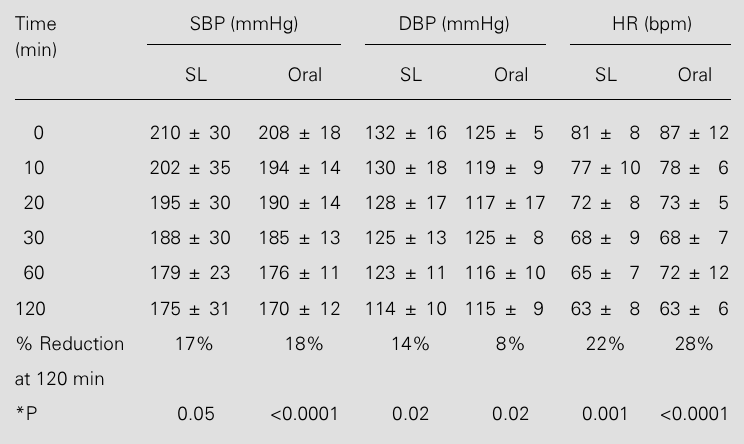
Table 3 - Hemodynamic parameters obtained before and after oral and sublingual propranolol administration. Data are reported as the mean – SD. SL, Sublingual route; SBP, systolic blood pressure; DBP, diastolic blood pressure; HR, heart rate. * t -test (baseline vs 120